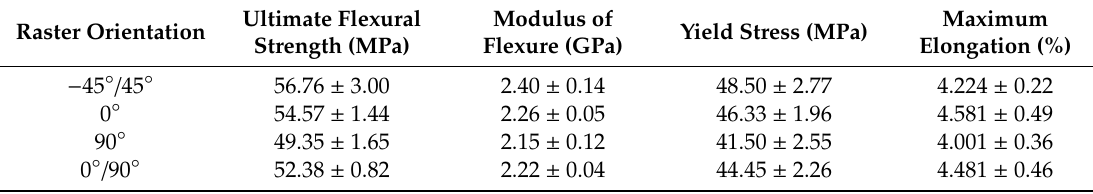
Figure 8. Representative Flexural Stress-Strain Curves. The 90° orientation resulted in the lowest ultimate flexural strength as well as the least ductility. This result matches intuition. Because it should be expected that side by side bonding would be not as strong as continuous length of material extruded (as in the 0° direction). The 0° and − 45°/45° orientation produced higher ultimate flexural strengths. Alternating orientation of 0°/90° had lower strength at the benefit of better ductility. Overall, the 0° orientation had the best fracture toughness by having comparable strength to the best results, while also being the most ductile.